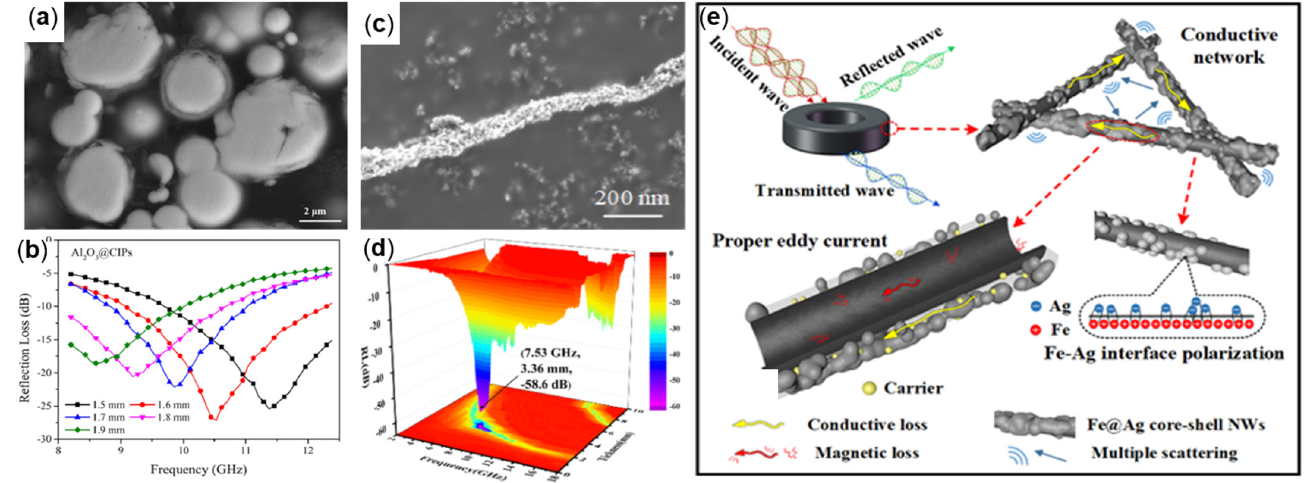
Figure 11. ( a ) SEM and ( b ) RL plot of Al @CIPs, reproduced with permission from Ref. [81], Copyright 2021, Elsevier. ( c ) SEM and ( d ) RL plot of Fe@Ag and ( e ) EM wave attenuation mechanism of Fe@Ag core-shell NWs, reproduced with permission from Ref. [83], Copyright 2022,